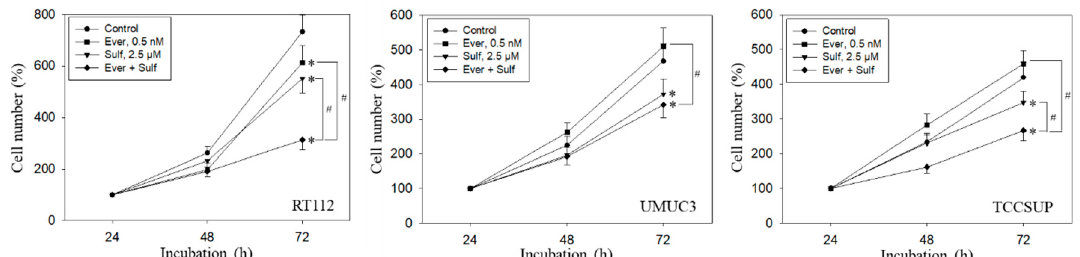
Figure 6. Growth of RT112, UMUC3, and TCCSUP cells exposed to 0.5 nM everolimus (Ever) or 2.5 µM sulforaphane (Sulf) or 0.5 nM everolimus + 2.5 µM sulforaphane (Ever + Sulf). Control cells (Control) remained unexposed. Cells were incubated in 96-well-plates for 24, 48, and 72 h. Cell number was set to 100% after 24 h incubation. Experiments were repeated five times. ∗ indicates significant difference to untreated controls. # indicates significant difference between the mono and combined applications.